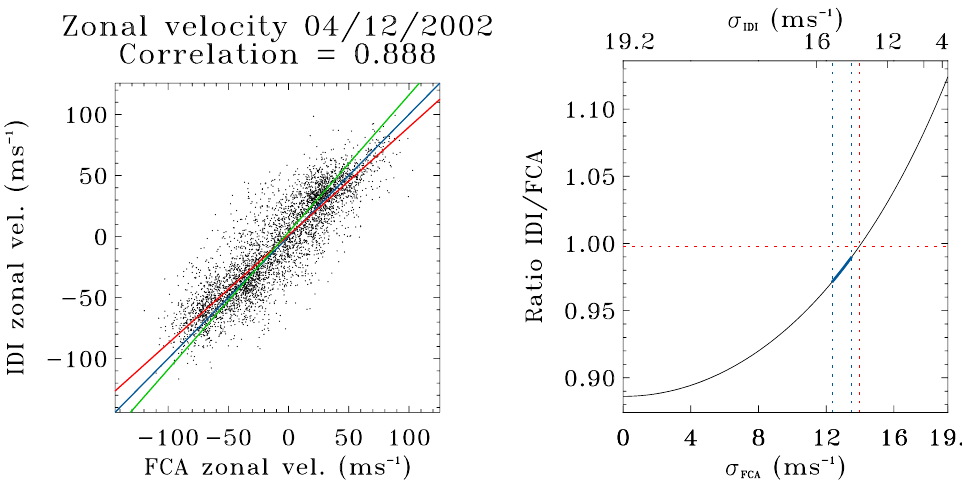
Fig. 5. Example of application of statistical comparison technique to FCA and IDI zonal velocities from 4 December 2002. Left: scatter plot of FCA vs. IDI velocities. The red and green lines indicate the results of the least-squares fit, assuming all measurement errors are present in the FCA and IDI velocities, respectively. The green line indicates FCA=IDI. Right: relationship between relative magnitude and FCA and IDI measurement errors. The blue lines indicate the range of values defined by the maximum measurement error estimated. The red dotted vertical and horizontal lines indicate equal measurement errors and the corresponding relative gains,